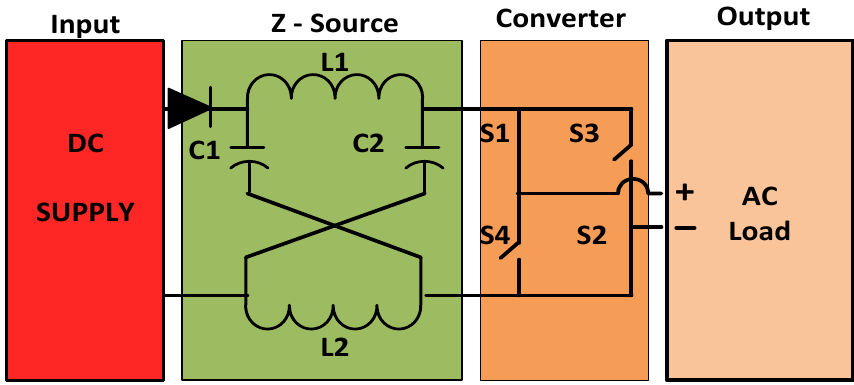
Figure 6. Z-Source DAD converter,inverter mode (positive half cycle).